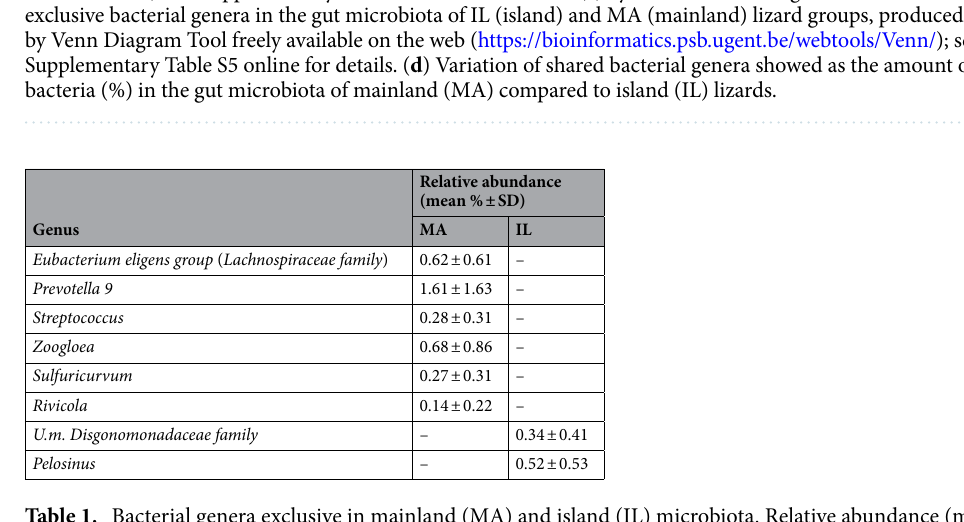
Table 1. Bacterial genera exclusive in mainland (MA) and island (IL) microbiota. Relative abundance (mean %) and standard deviation (SD) of bacterial genera present exclusively in mainland (MA) and island (IL)